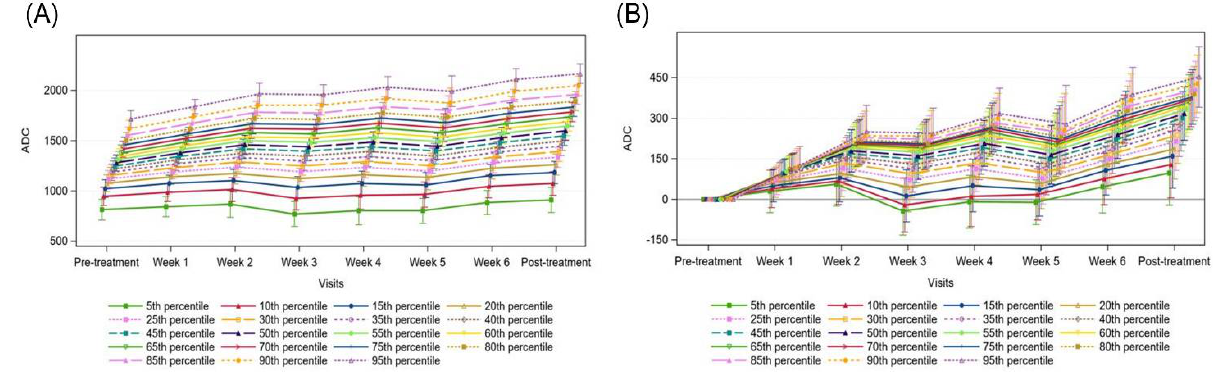
Figure 3. Absolute Apparent Diffusion Coefficient (ADC) measurements, ( A ) and mean ADC change from pre-treatment, ( B ) for the primary tumour, with 95% confidence intervals.